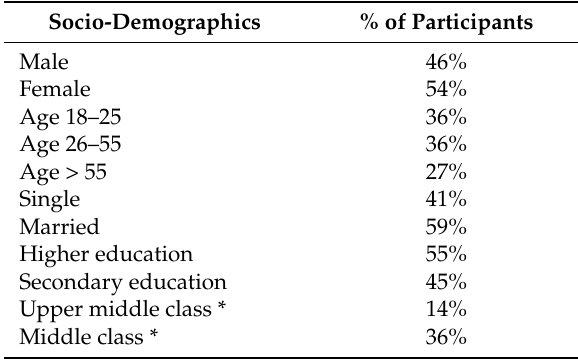
Table 2. Socio-demographic profile of the participants of the focus